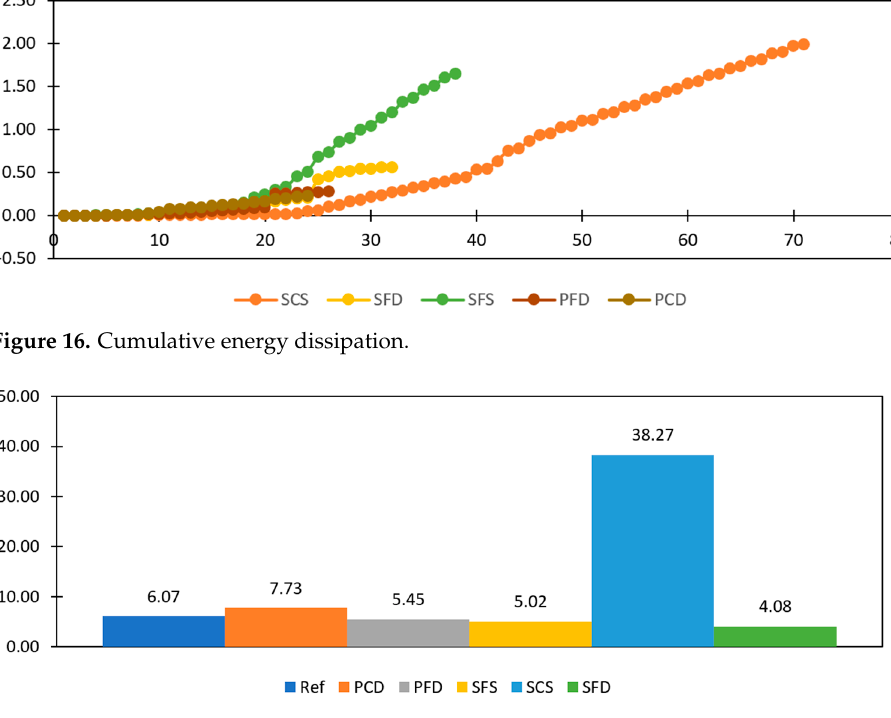
Figure 17. Ductility factor